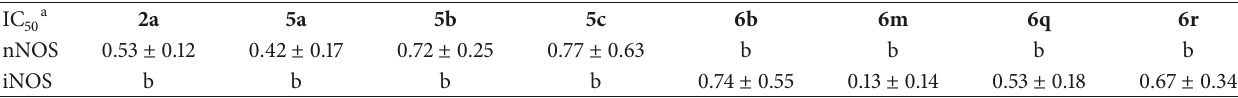
Table 2: IC 50 values (mM) for the inhibition of nNOS activity of compounds 5a–c and iNOS activity of 6b , 6m , 6q, and 6r . Pyrazoline 2a has been included as a control